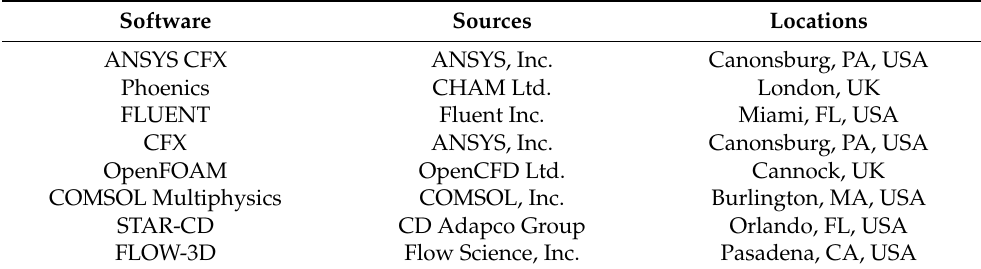
Table 2. Examples of some commonly used commercial CFD software